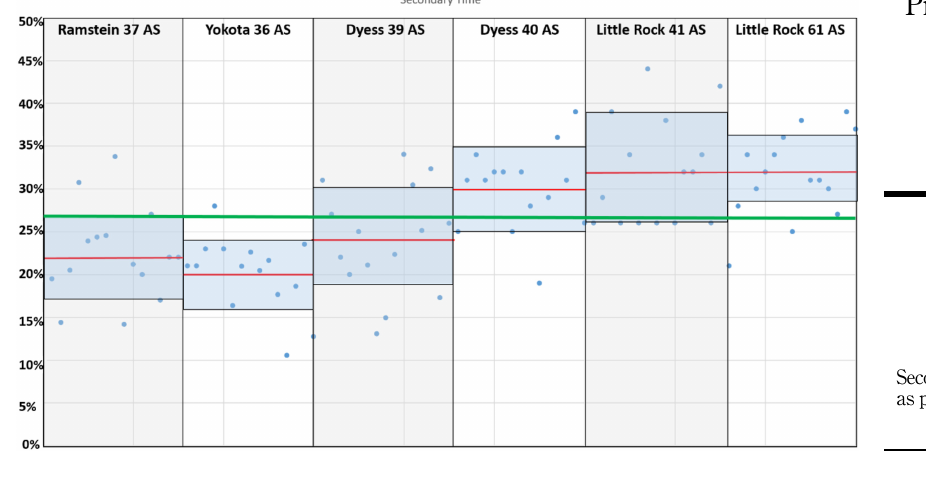
Figure 3. Secondary flight time